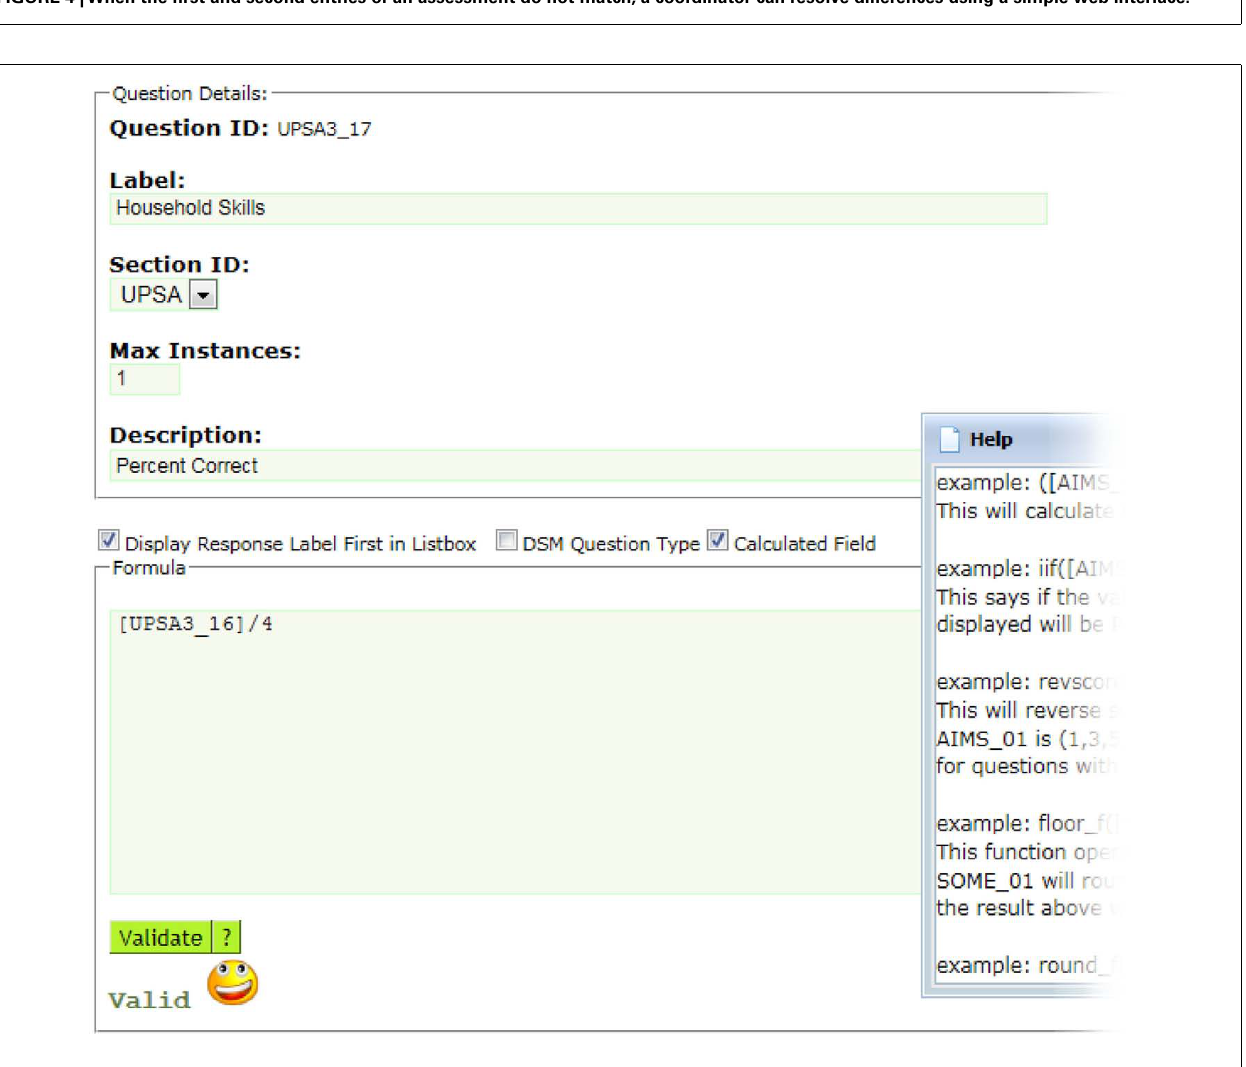
types of fields: free-form text and drop-down list. There are no radio buttons, sliders, checkboxes, graphics, or other